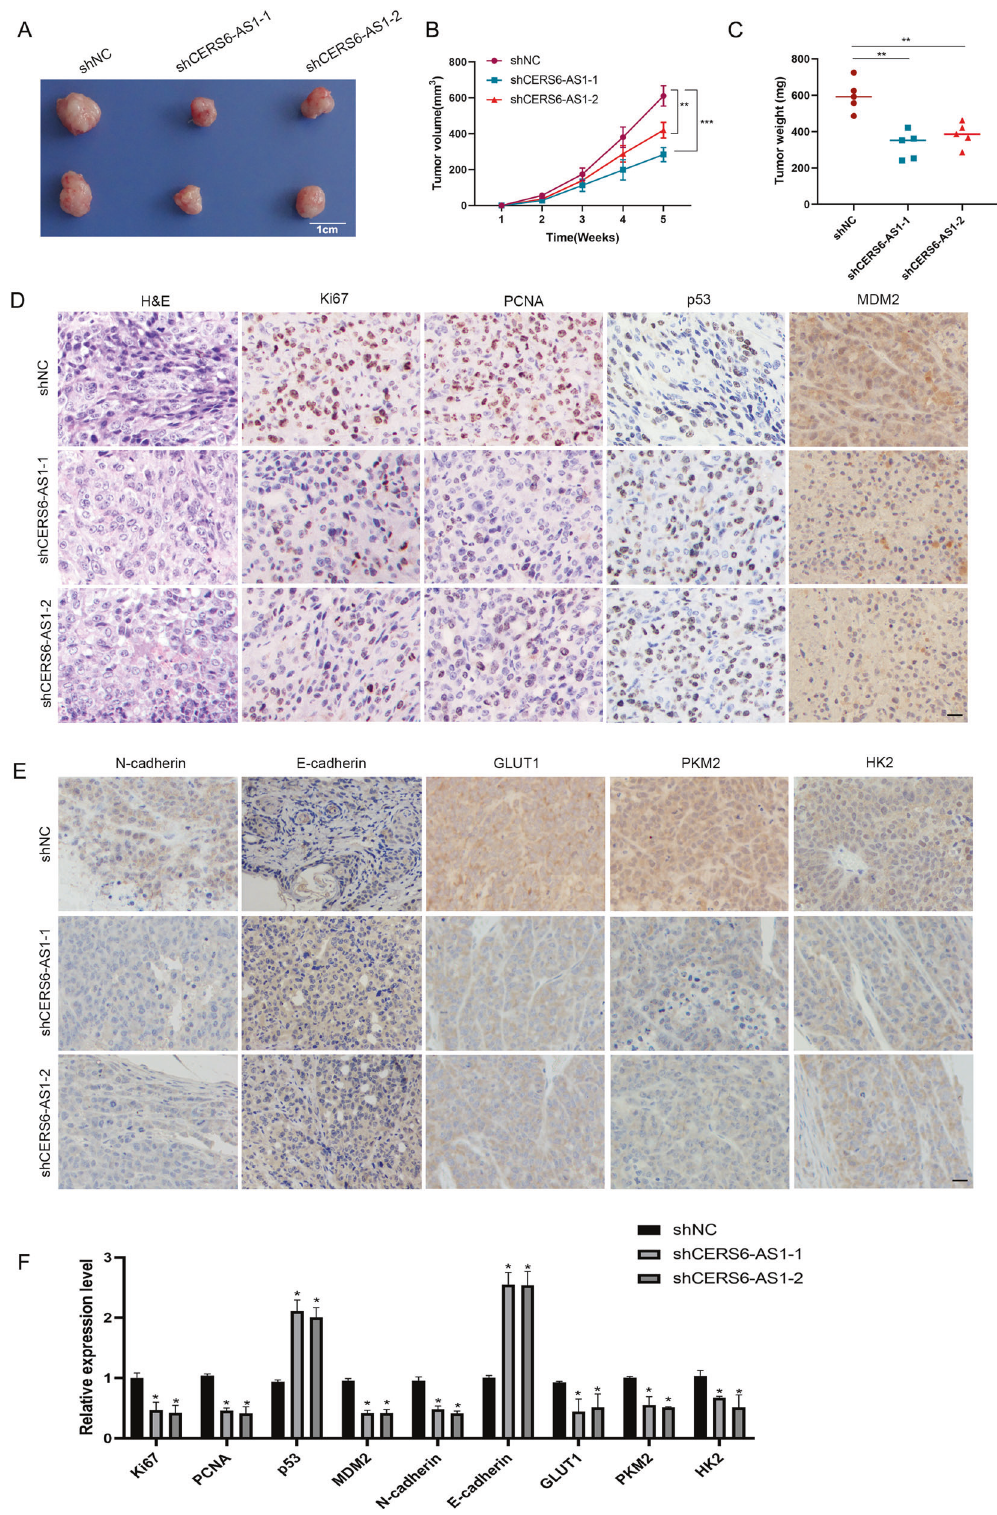
Fig. 8 LncRNA CERS6-AS1 accelerates HCC proliferation in vivo. A Morphologic characteristics of xenograft tumors from HepG2/shNC group and HepG2/shCERS6-AS1 group ( n = 5, scale bar: 1 cm). B The volume of xenograft tumors. C The weight of xenograft tumors. D Representative images of H&E, Ki67, PCNA, p53 and MDM2 staining in the xenograft tumors and the relative expression levels in shNC and shCERS6-AS1 groups. Scale bar: 100 μ m. E Representative images of MDM2, N-cadherin, E-cadherin, GLUT1, PKM2 and HK2 staining in the xenograft tumors and the relative expression levels in shNC and shCERS6-AS1 groups. Scale bar: 100 μ m. F The statistical analysis of these protein expression levels in shNC and shCERS6-AS1 groups. * p < 0.05, ** p <